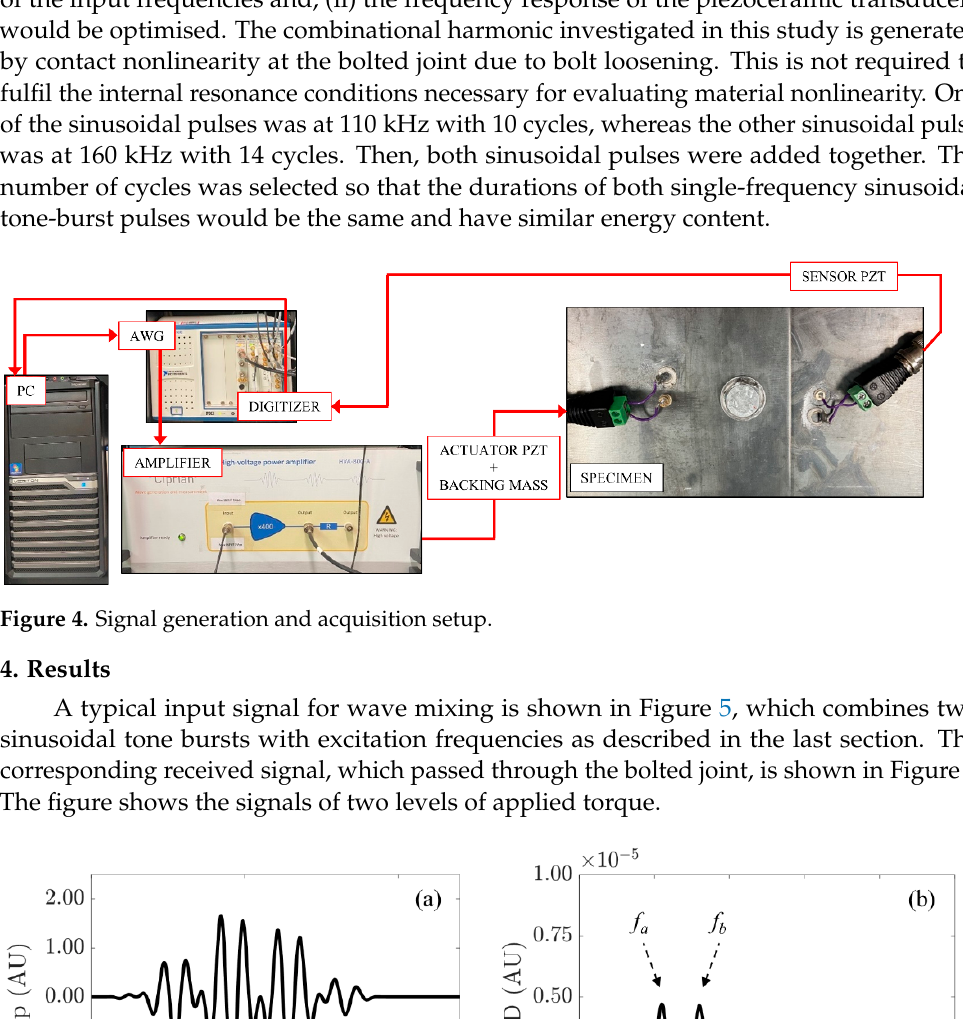
Figure 4. Signal generation and acquisition setup.